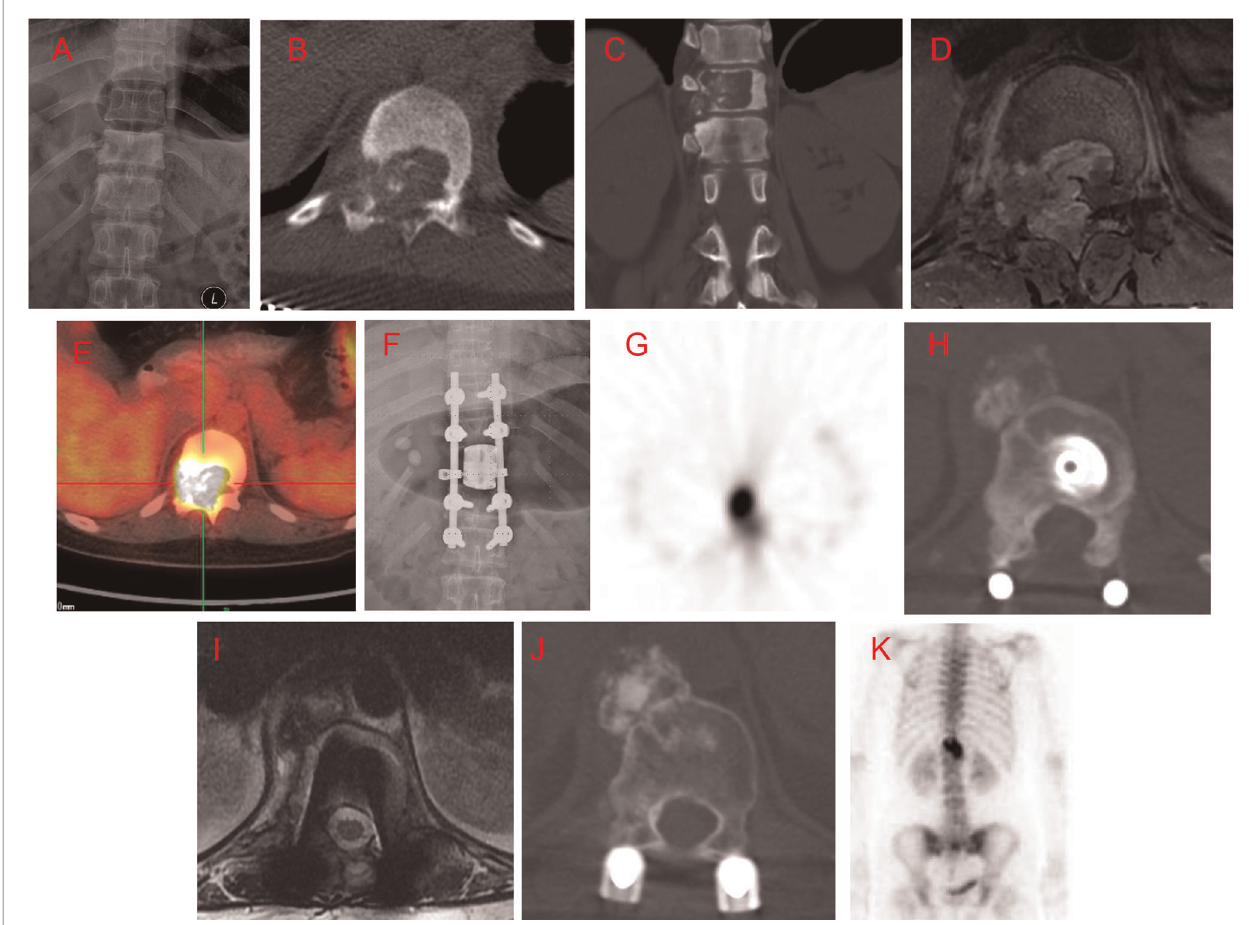
FIGURE 1 | Case 4. A 28-year-old female patient with low back pain for 6 months, with rapid symptom progression to paralysis of the lower extremities within 2 weeks. An osteolytic lesion was located in the T11 vertebral body, right pedicle, transverse process, and lamina. She underwent an intralesional vertebrectomy; however, computed tomography (CT) and isotope bone scans at 20 months postoperative revealed a local recurrence. She underwent radiotherapy but refused advanced surgery. The recurrent lesion was stable and gradually ossi fi ed, as seen at the 16-month follow-up after radiotherapy. ( A ) Preoperative posteroanterior radiography. ( B,C ) Preoperative axial and coronal CT scans. ( D ) T2-weighted magnetic resonance imaging (MRI) scan. ( E ) Preoperative positron emission tomography-CT (PET-CT). ( F ) Posteroanterior radiography 1 week postoperatively. ( G ) Isotope bone scan 20 months postoperatively. ( H ) Axial CT scan 20 months postoperatively. ( I ) T2-weighted MRI scan 20 months postoperatively. ( J ) Axial CT scan 16 months after radiotherapy. ( K ) Isotope bone scan 16 months after